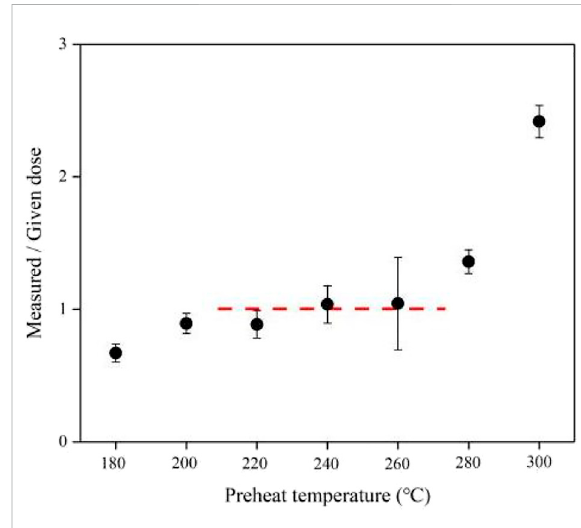
FIGURE 2 Dose recovery test results for 38 – 63 μ m quartz in sample YLJ-19.Threealiquotswereusedperpreheatingtemperature.The dashed line is drawn at the average De of the aliquots measured with preheating temperatures between 220 and 260 °